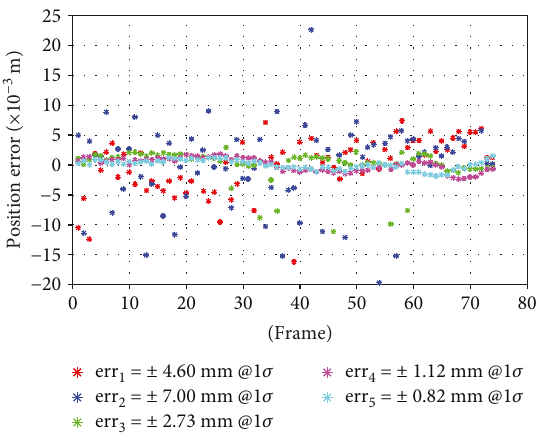
Figure 35: Position error of each marker, frame by frame, considering a test point with only 5 best